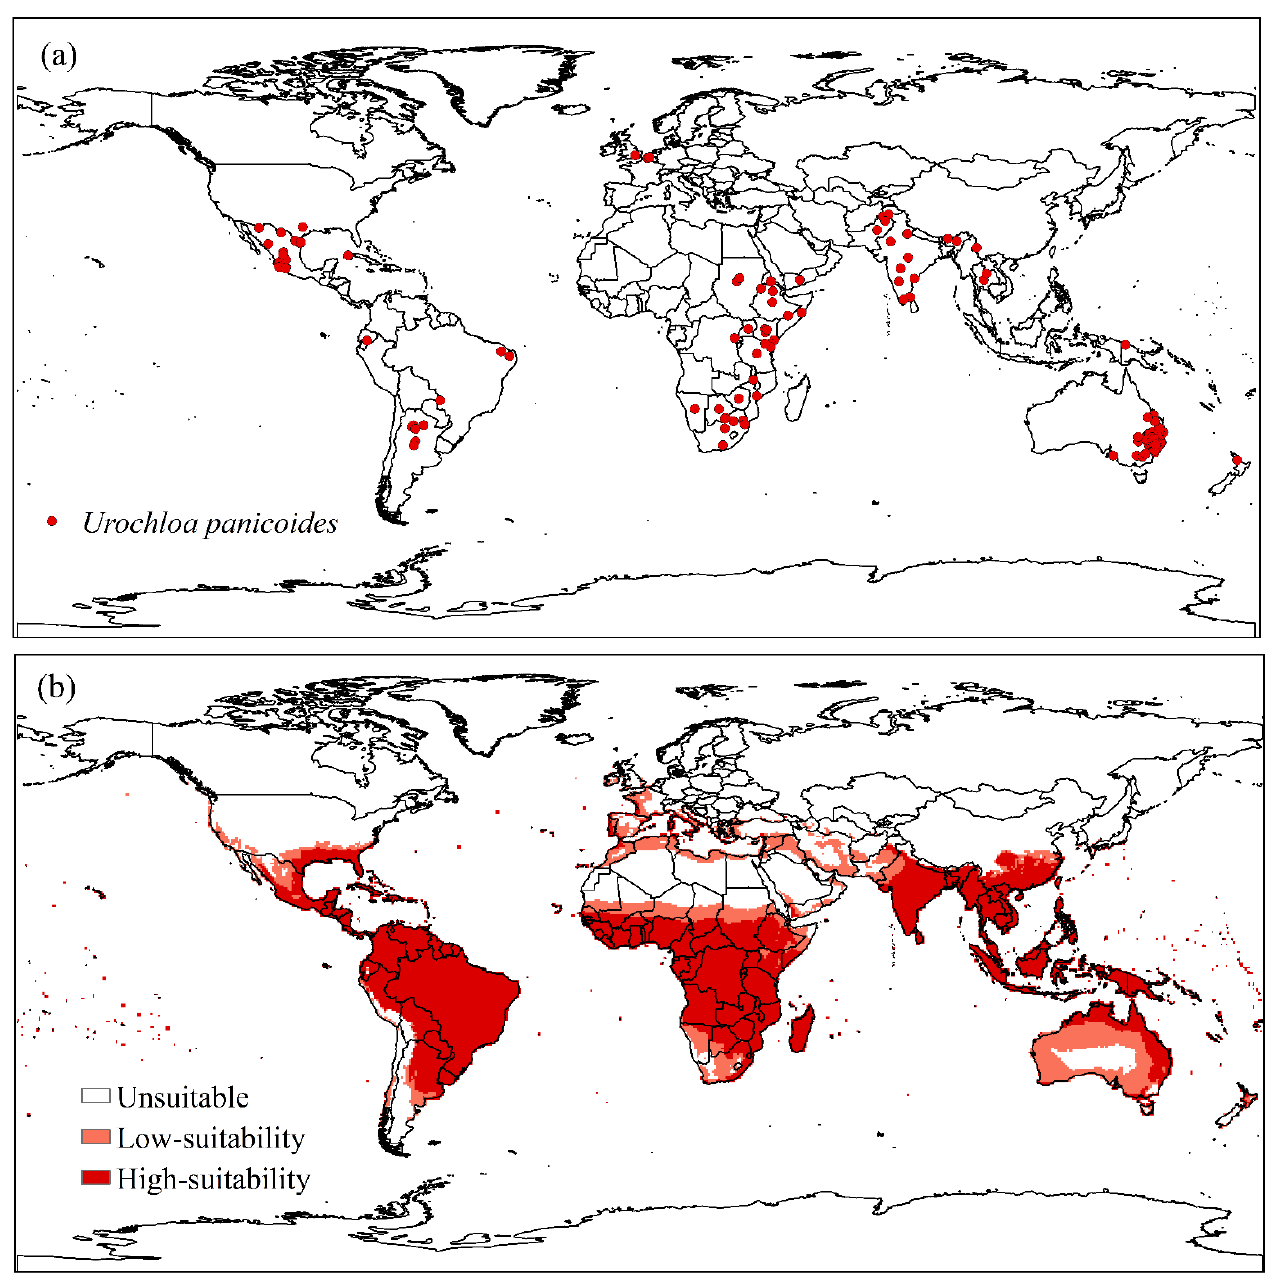
Figure 2. ( a ) Global distribution of Urochloa panicoides and ( b ) Ecoclimatic Index (EI) of U. panicoides , modeled using CLIMEX. Unsuitable areas in white (EI = 0), low-suitability areas in light red (0 < EI < 30), and high-suitability areas in red (30 < EI < 100).